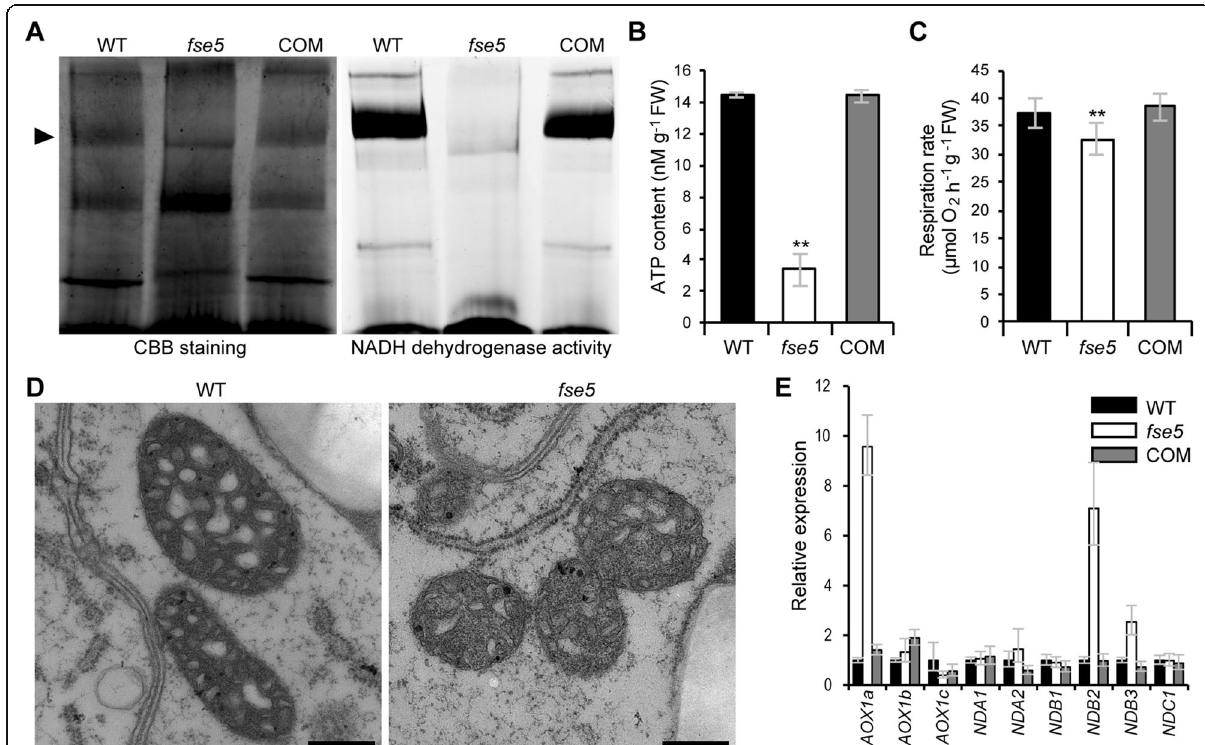
Fig. 7 Mitochondrial function and structure were disrupted in fse5 mutant cells. a Mitochondrial complexes separated by BN-PAGE and stained with Coomassie brilliant blue (CBB) (left) and in-gel NADH dehydrogenase activity of complex I (arrow) (right). b and c Measurement of ATP contents ( b ) and respiration rates ( c ). The values are the means ± SDs. **, P < 0.01, Student ’ s t test. d Mitochondria in developing endosperm cells of the WT and fse5 seeds at 9 DAF. Bars, 0.5 μ m. e Expression of AOX-encoding genes ( AOX1a , AOX1b and AOX1c ) and alternative NADH dehydrogenase-encoding genes ( NDA1 , NDA2 , NDB1 , NDB2 , NDB3 , and NDC1 ) in nine-day-old seedlings. Specific primers were used for qRT-PCR (Toda et al. 2012; Li et al. 2013). The data are based on three biological replicates. OsActin1 was used as an internal control for data normalization. The values are the means ±